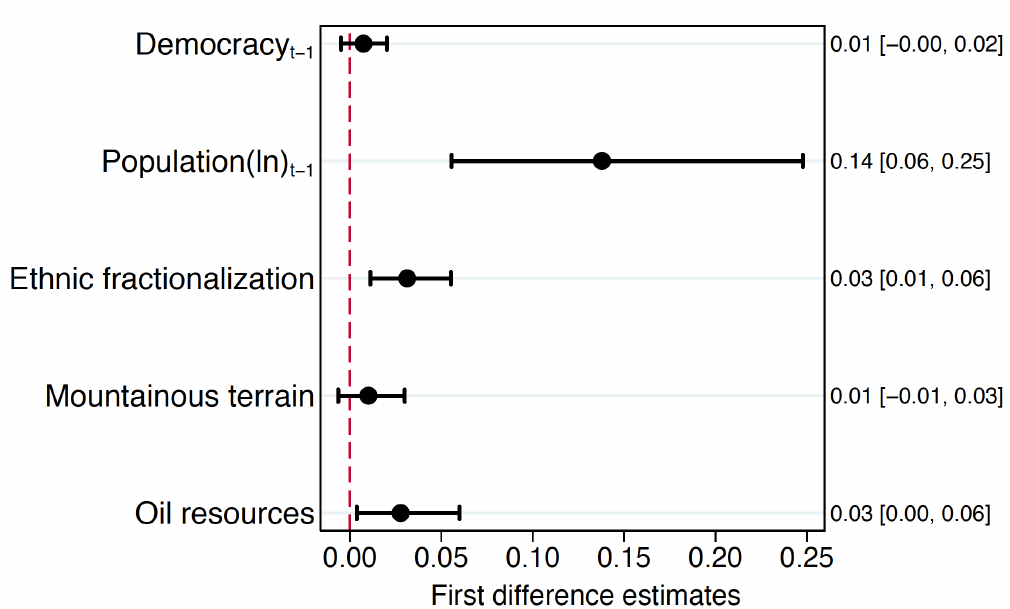
Figure 2. Substantive effects for control variables. Note: The first difference indicates the change in the probability of the dependent variable = 1 (Civil war risk=1) when changing a respective explanatory variable from its minimum to its maximum, while holding all other variables at their median values. The horizontal bars pertain to 90 percent confidence intervals. The vertical dashed line marks a first-difference estimate of